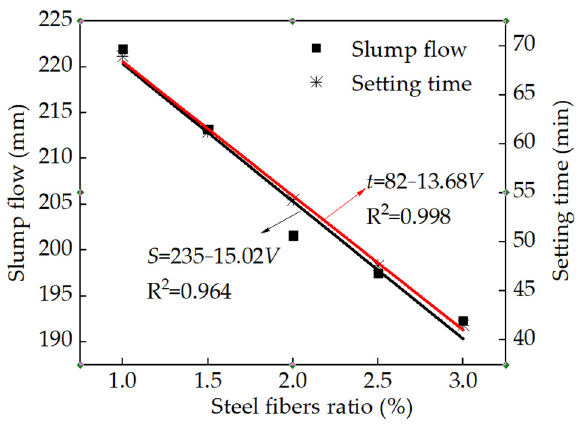
Figure 4. The slump flow and setting time of fresh reactive powder concrete.